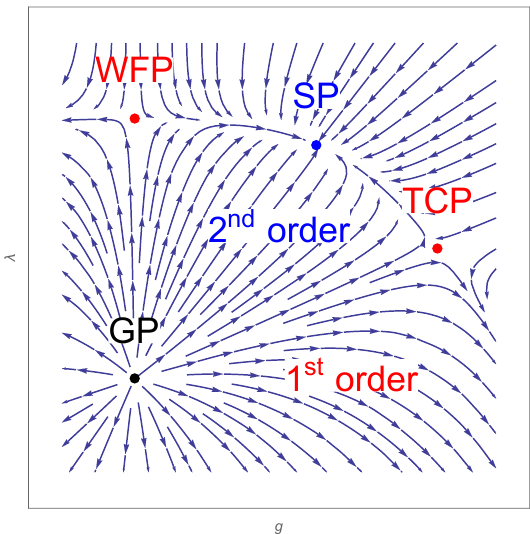
Figure 2: The RG flow for the model (24) when N φ = N χ = 1. F.p.’s are marked by dots, where the black dot is the fully repellent Gaussian f.p. (GP), the red dots (WFP and TCP) define a separatrix that separates regions corresponding to first- and second-order phase transitions and the blue dot is a fully attractive f.p. (SP) that is stable in the IR. The order parameter for the first order transition corresponds to 〈 φ 〉